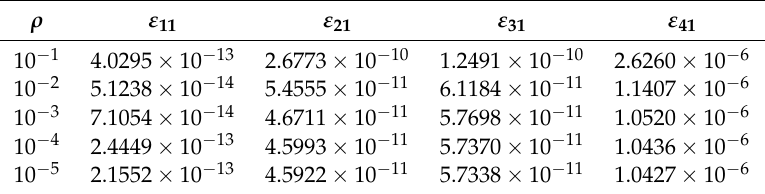
Table 3. ε 11 , ε 31 together with their upper bounds ε 21 , ε 41 of Example 1.